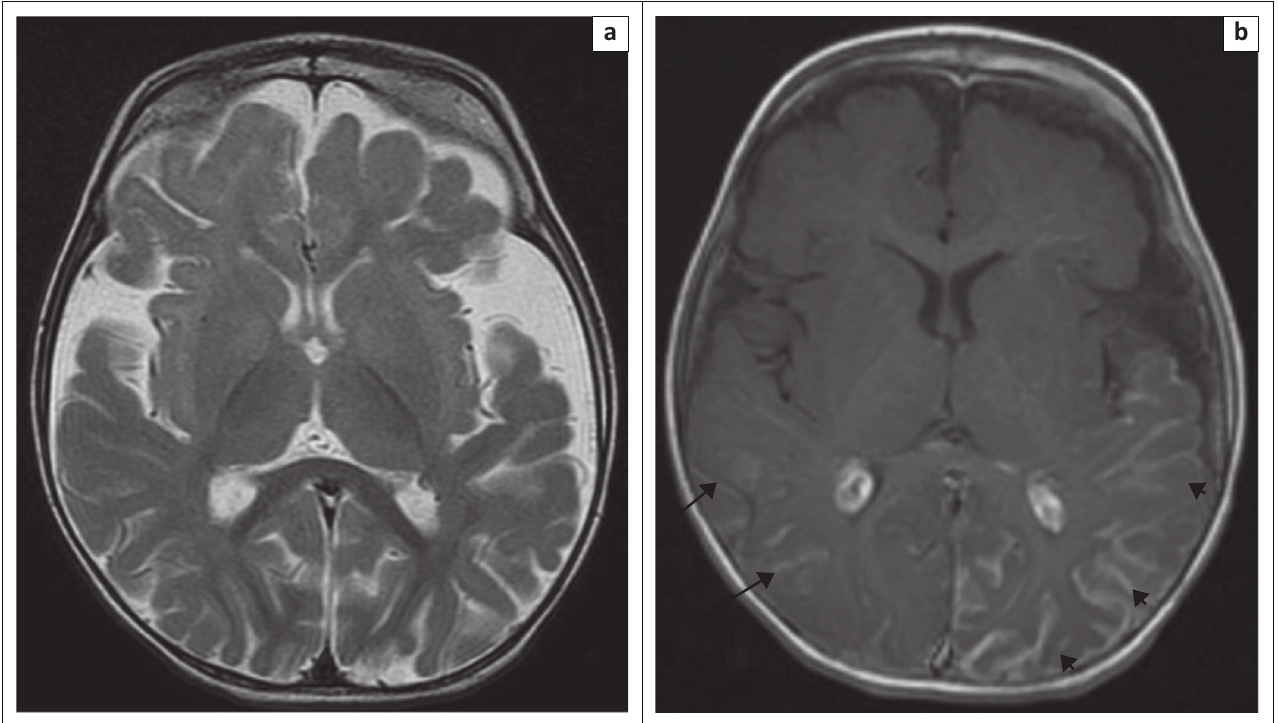
FIGURE 5: An 8-month-old girl with bilateral facial port-wine stains, seizures and congenital glaucoma. Axial T2W (a) demonstrates cerebral atrophy. Contrast-enhanced axial T1W (b) shows leptomeningeal enhancement involving both cerebral hemispheres, left side (arrowheads) greater than right (arrows), consistent with bilateral Sturge-Weber syndrome.